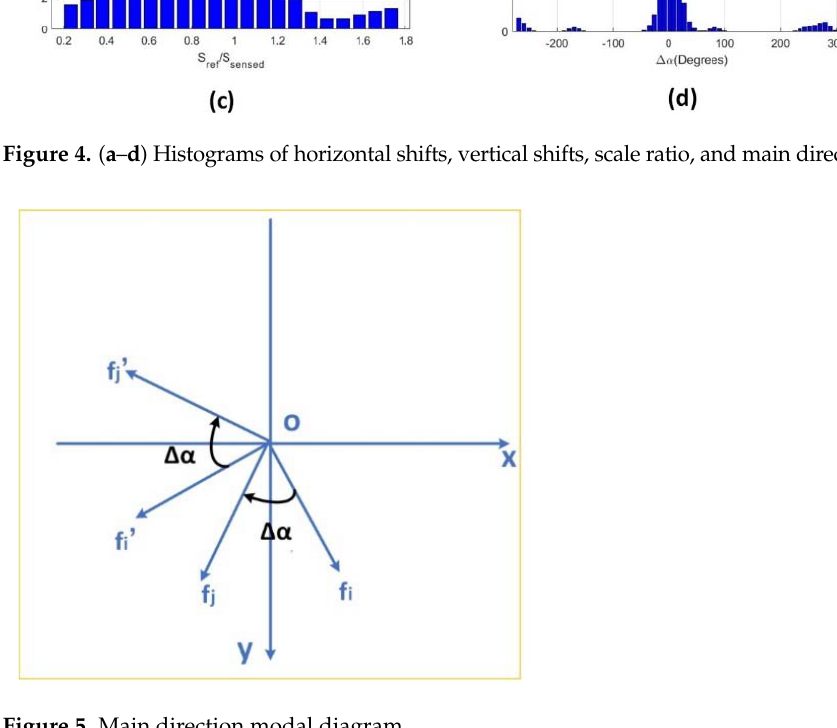
Figure 5. Main direction modal